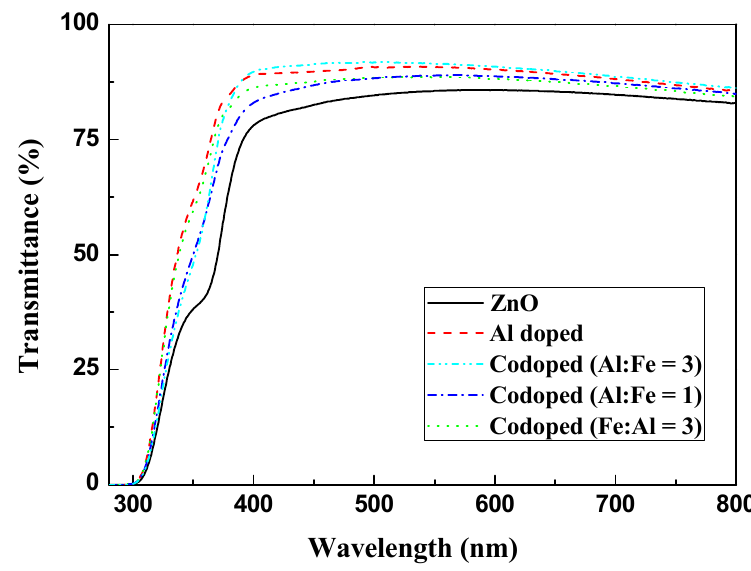
Figure 6. Transmittance spectra of different ZnO films.